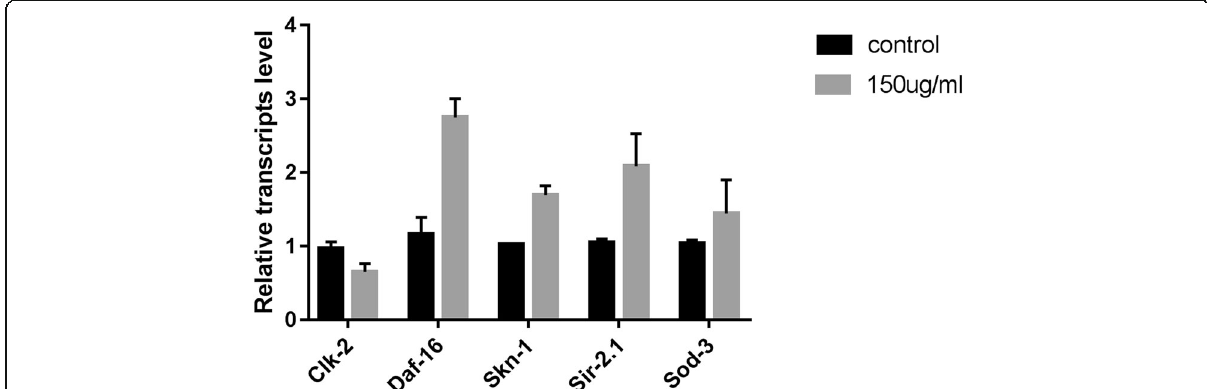
Fig. 5 Effects of JPYW treatment on the expression of aging-related genes. The expression levels of aging-related genes were determined by qRT-PCR using the 2 − ΔΔ CT method in worms with or without 150 μ g/ml JPYW treatment at 20 °C . The graph shows the mean and SEM values from two independent experiments. Compared to the control treatment, JPYW treatment significantly changed the expression levels of the genes daf-16, clk-2, skn-1 and sir-2.1 ( P < 0.05), but not those of the gene sod-3 ( P >